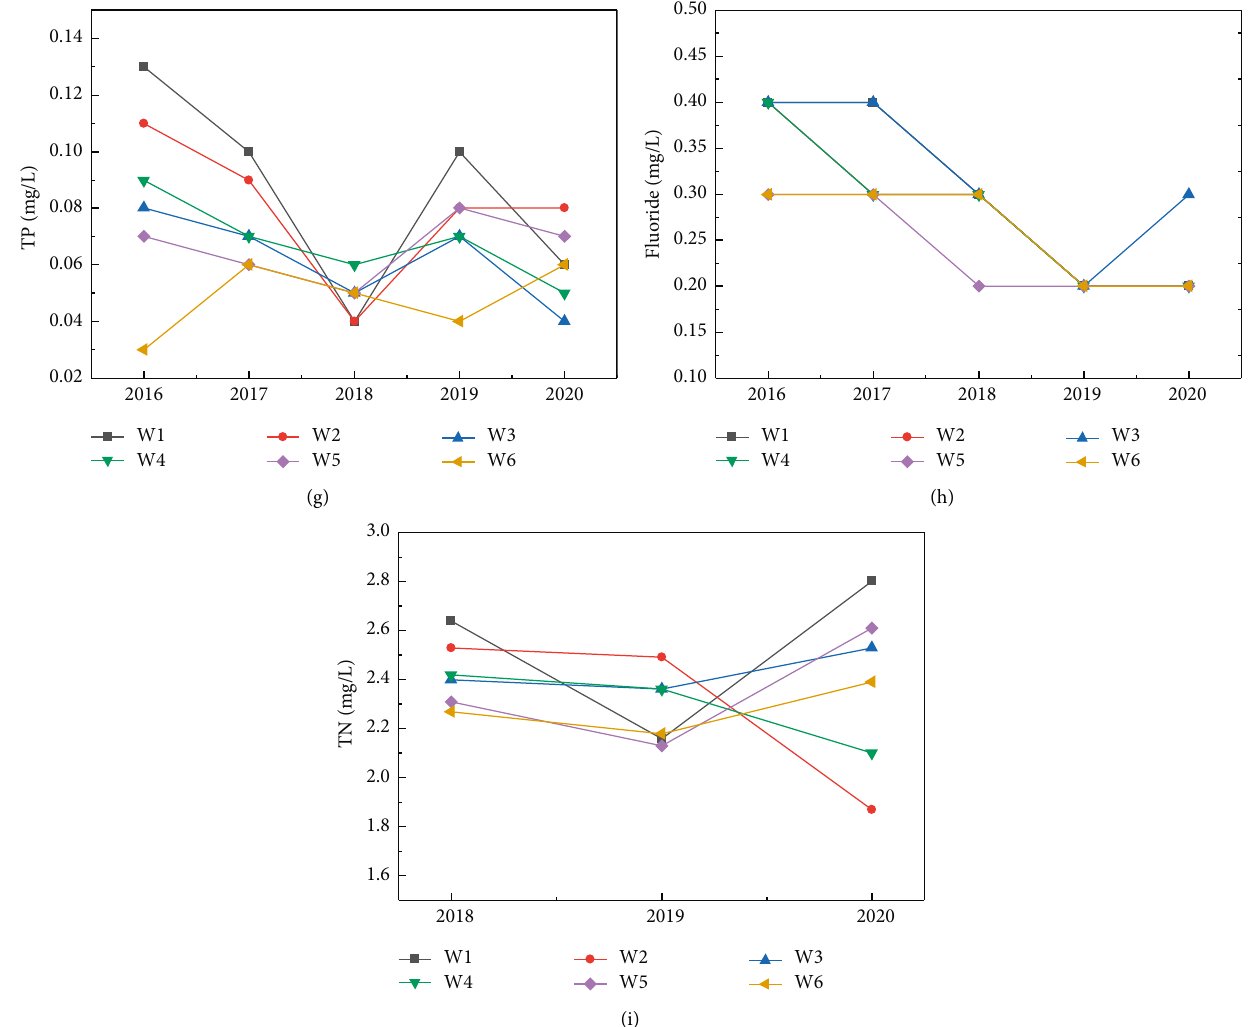
Figure 2: Variation of water quality parameters of the Ningxia section of the yellow river during